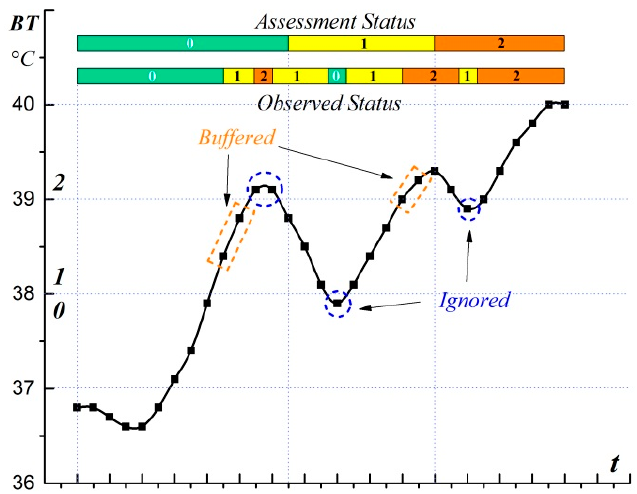
Figure 9. Assessment demonstration during the observation of body temperature.